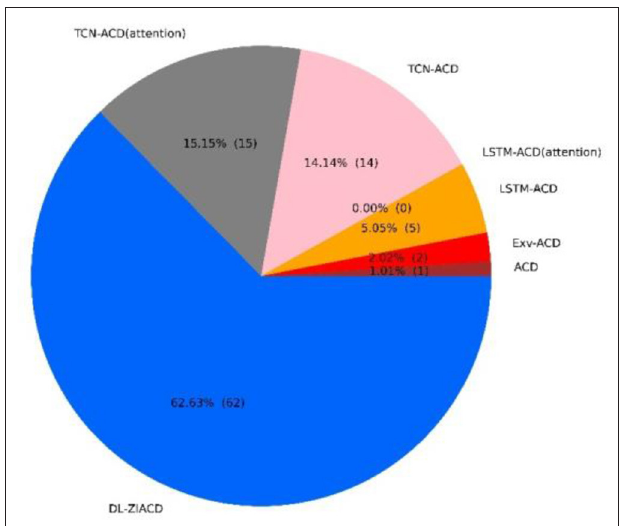
FIGURE 3 | Detailed comparison of the seven models in MAE duration by a pie chart [the size of each pie slice represents the percentage (number) of stocks on which the corresponding model achieves the lowest MAE duration ].